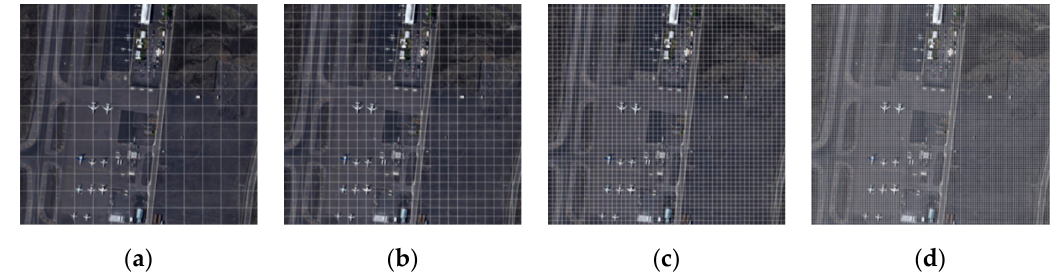
Figure 4. Receptive field of the same aerial remote sensing image at different scales: ( a ) 13 × 13; ( b ) 26 × 26; ( c ) 52 × 52; ( d ) 104 × 104.